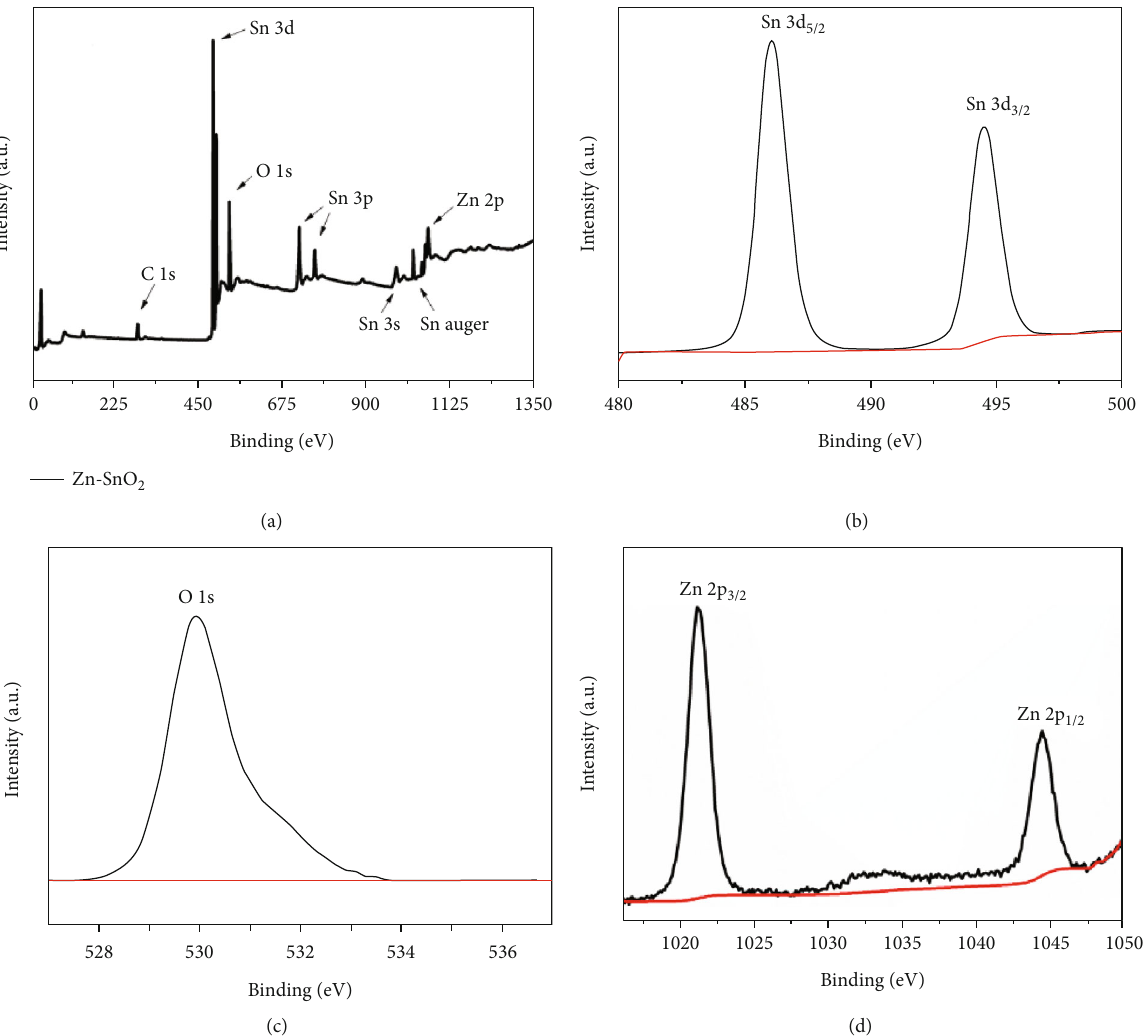
fi lm and XPS spectra of (b) Sn 3d core level, (c) O 1s core level, and (d) Zn 2p core level peak for the Zn- 2